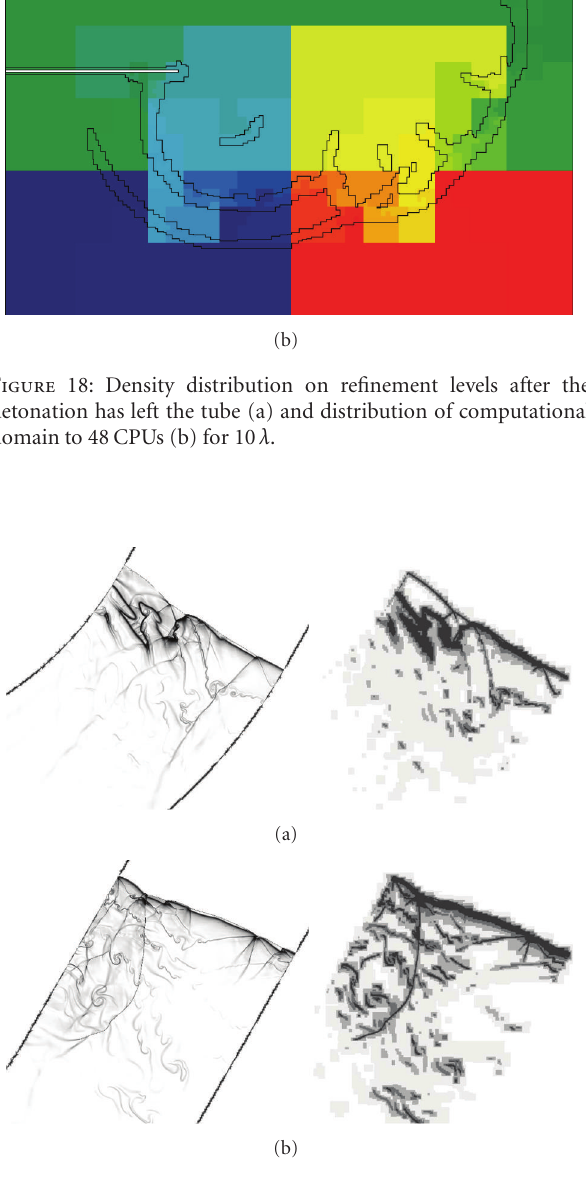
Figure 19: Schlieren plots of the density (left) show the partial decoupling of shock and reaction zone in the bend at t = 200 μ s (a) and the reflected transverse re-ignition wave at t = 250 μ s (b). The corresponding dynamic refinement is shown in the right graphs.